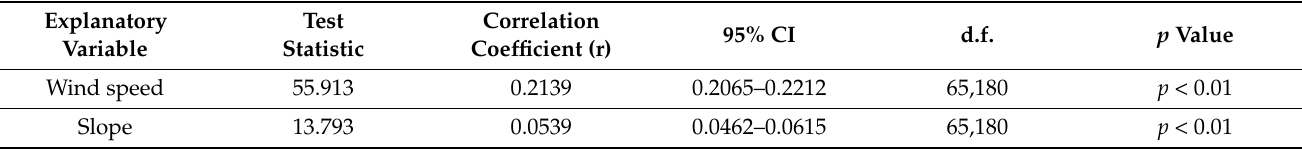
Figure 5. Shelter ratio (reduction in wind speed from ambient weather station normalised to a value of 1) for south easterly wind direction. Shelter structures are depicted with green outline and no estimated shelter effect within the shelter. Artificial shelters are visible as the irregular shapes near the top of the field and natural shelters are larger and distributed around the perimeter of the field. Table 7. Spatial correlation of slope and wind speed with z-scores outputs from hotspot (Getis-Ord Gi*) analysis for the prevailing south easterly wind